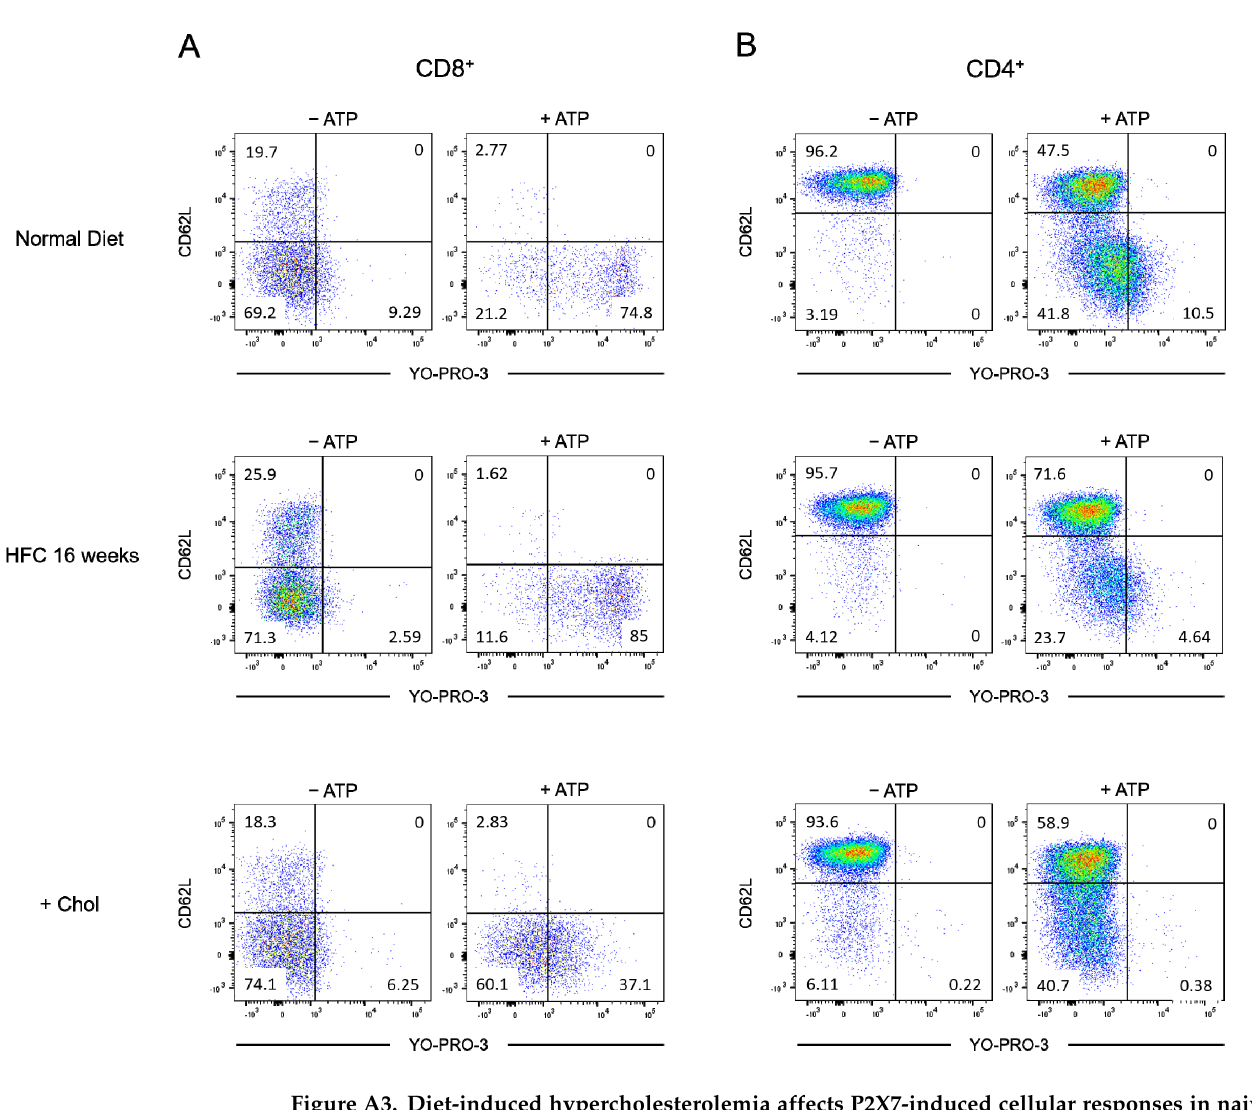
Figure A3. Diet-induced hypercholesterolemia affects P2X7-induced cellular responses in naive and effector/memory CD8 + and CD4 + T cells . Flow cytometry dot plots representative of the P2X7-induced cellular function assay performed on CD8 + ( A ) and CD4 + ( B ) T-cell subsets from mice fed either a normal diet (ND) or a high-fat diet (HFC) maintained for 16 weeks or on splenocytes from normal fed mice treated ex vivo with MBCD/Chol complexes (+Chol).